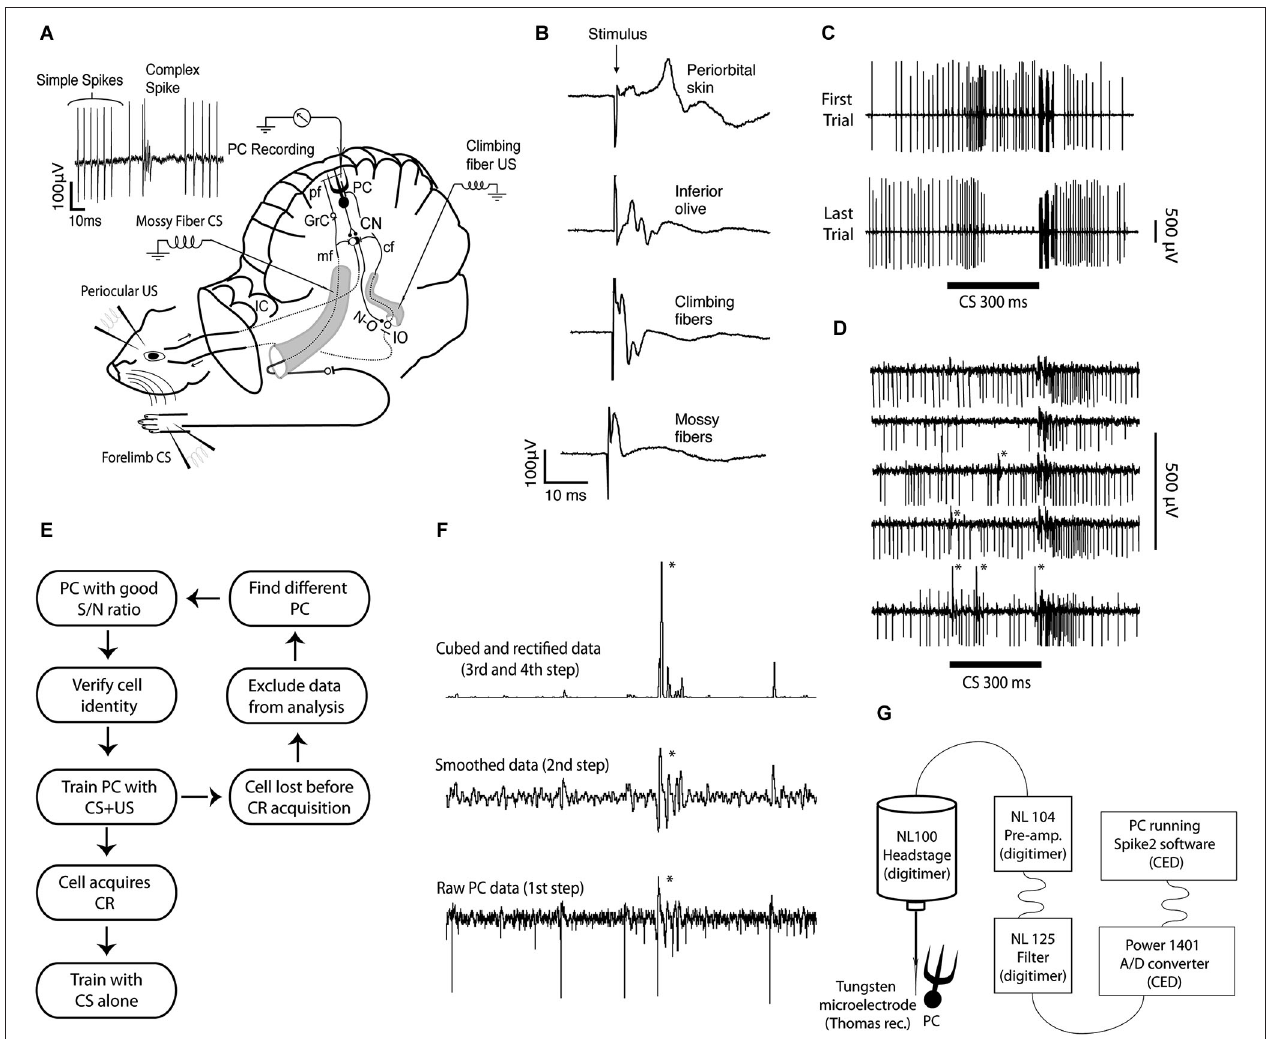
muscles, as well as to the IO, via the GABAergic nucleo-olivary pathway (N-O). (B) Field potentials recorded in the C3 zone, on the surface of the cerebellar cortex, following stimulation of different sites along the CS and US pathways. (C) The response of a single Purkinje cell before and after acquisition of a conditioned pause response or Purkinje cell CR. (D) Records from a Purkinje cell illustrating an increased complex spike probability in the early part of the CS. (E) Schematic diagram illustrating the strategy for obtaining data. (F) Illustration of the semiautomatic procedure used to sort complex spikes. Because a complex spike typically has one or more secondary spikes, smoothing the record will make them stand out. If the record is subsequently rectified, and then squared or cubed, these differences will be amplified. Still visual inspection is usually necessary